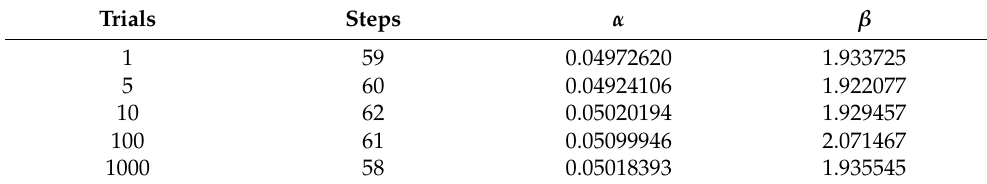
Table 2. Estimated average values of the parameters obtained using the Nelder–Mead algorithm as a function of the number of trials and the number of iteration steps for α = 0.05, β = 2, and 0 ≤ t ≤ 5. Trials Steps